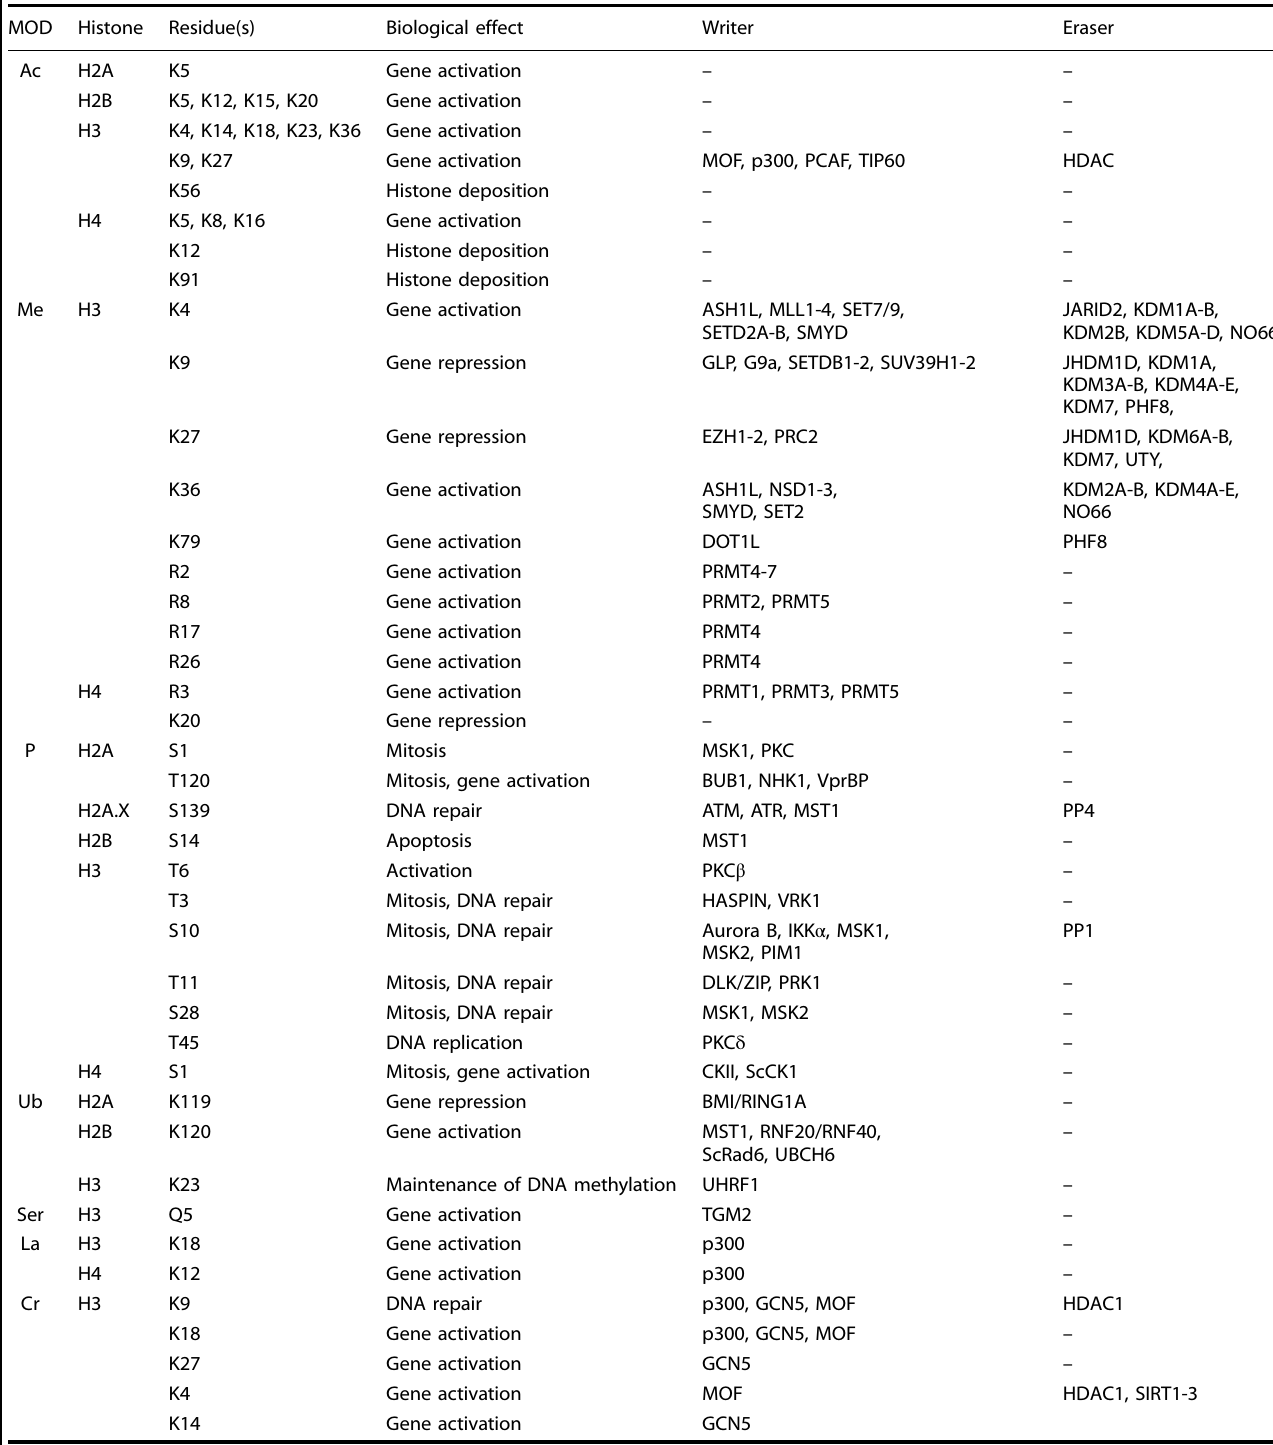
Table 1. Writer, eraser, and biological effect of histone modi fi cations MOD